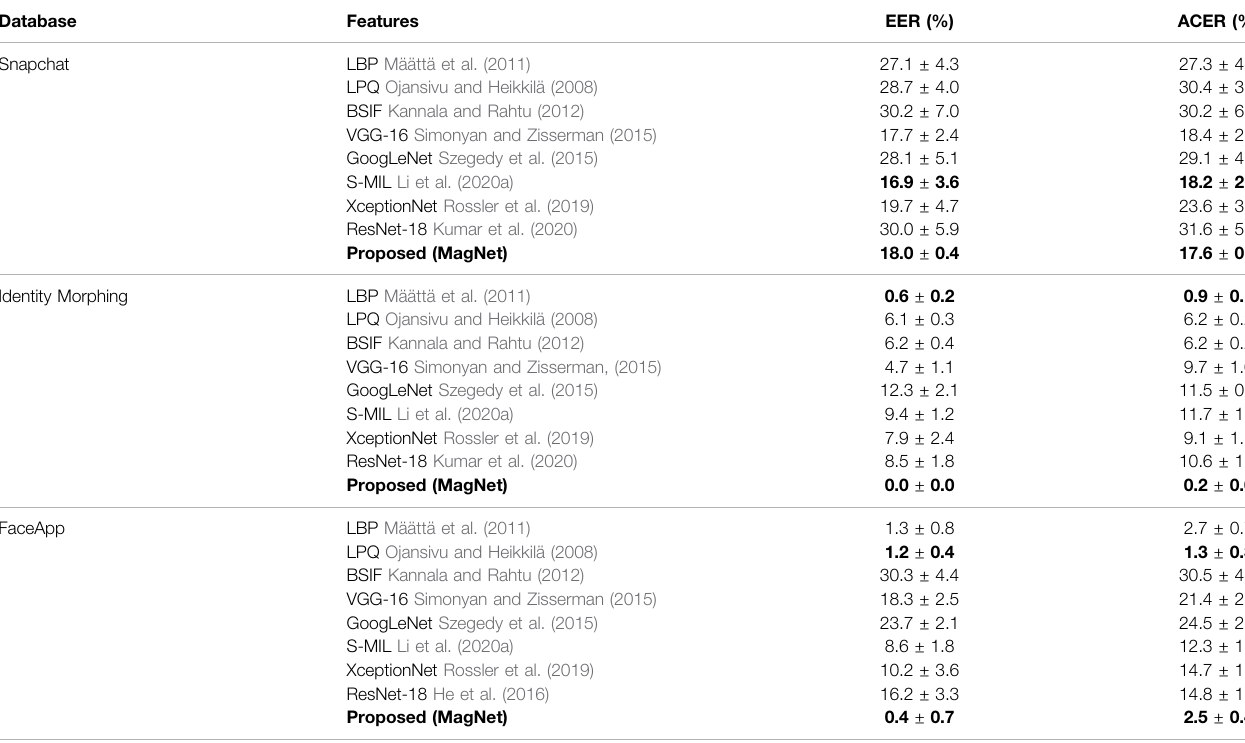
TABLE 5 | Results of the proposed MagNet and existing algorithms on the proposed ID Age nder databases using frames/images as input.